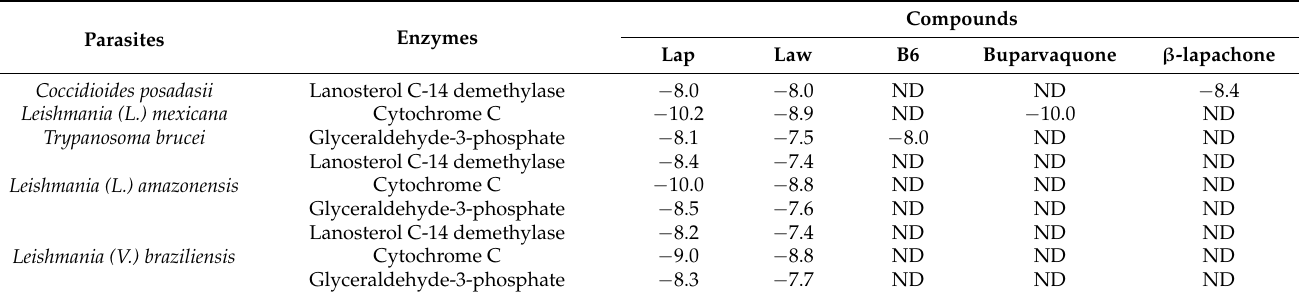
Table 1. Comparison of the docking energy (kcal/mol) of complexes from the assessed enzymes with ligands. Parasites